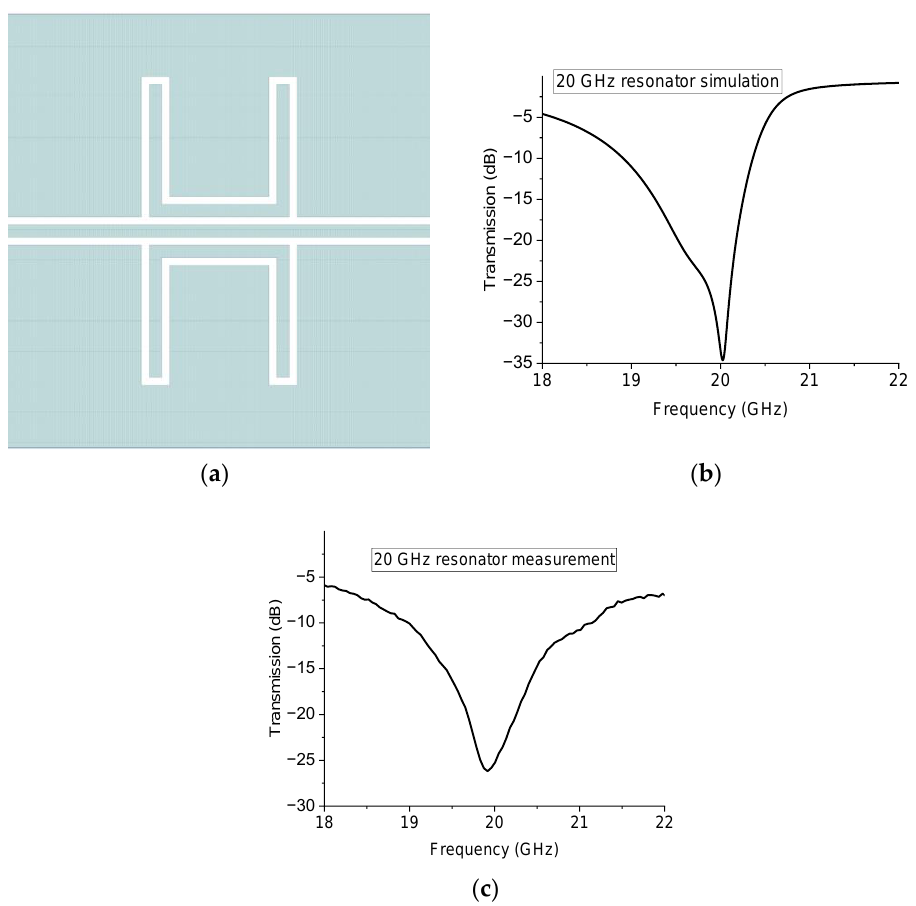
Figure 11. Symmetric implementation of the U-resonator for the 20 GHz. In ( a ) the resonator is mirrored on the other side of the central conductor of the CPW. Its predicted performance operation is shown in ( b ) and the experimental response is plotted in ( c ).